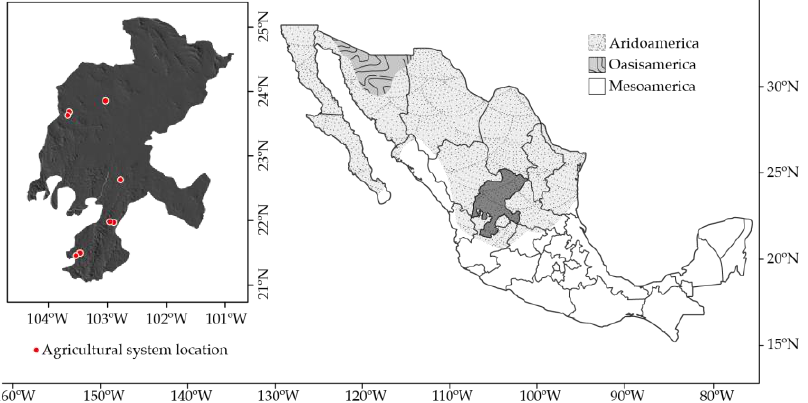
Figure 1. Agricultural systems location under study. On the map showing current political division of Mexican Republic; Mesoamerica, Aridoamerica, and Oasisamerica regions are